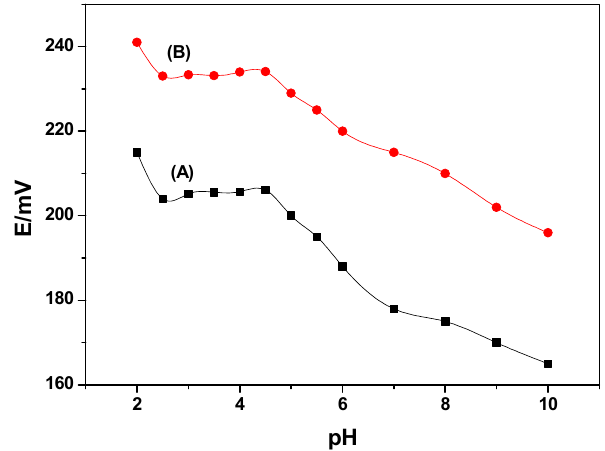
Figure 6. pH plot for (A) MIP(IPU)/multiwalled carbon nanotubes (MWCNTs)-ISEs and (B) MIP(DU)/MWCNTs-ISEs.